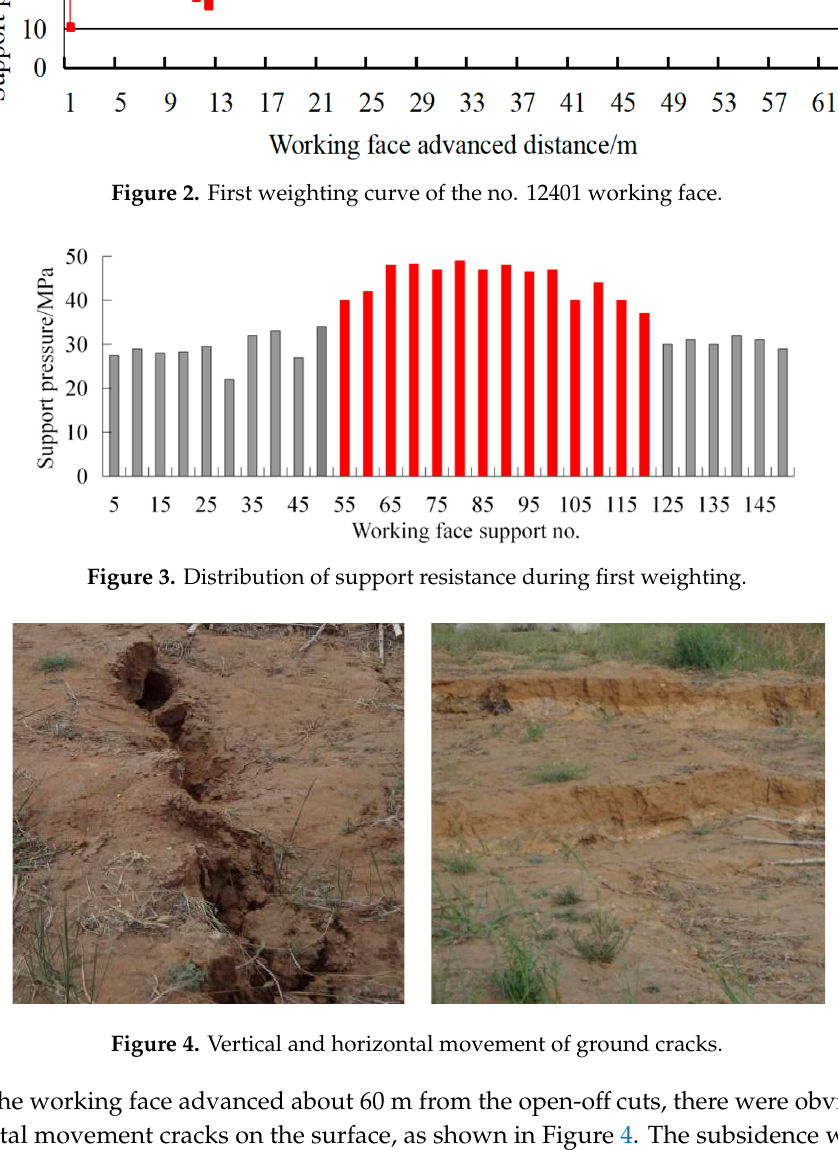
Figure 4. Vertical and horizontal movement of ground cracks.